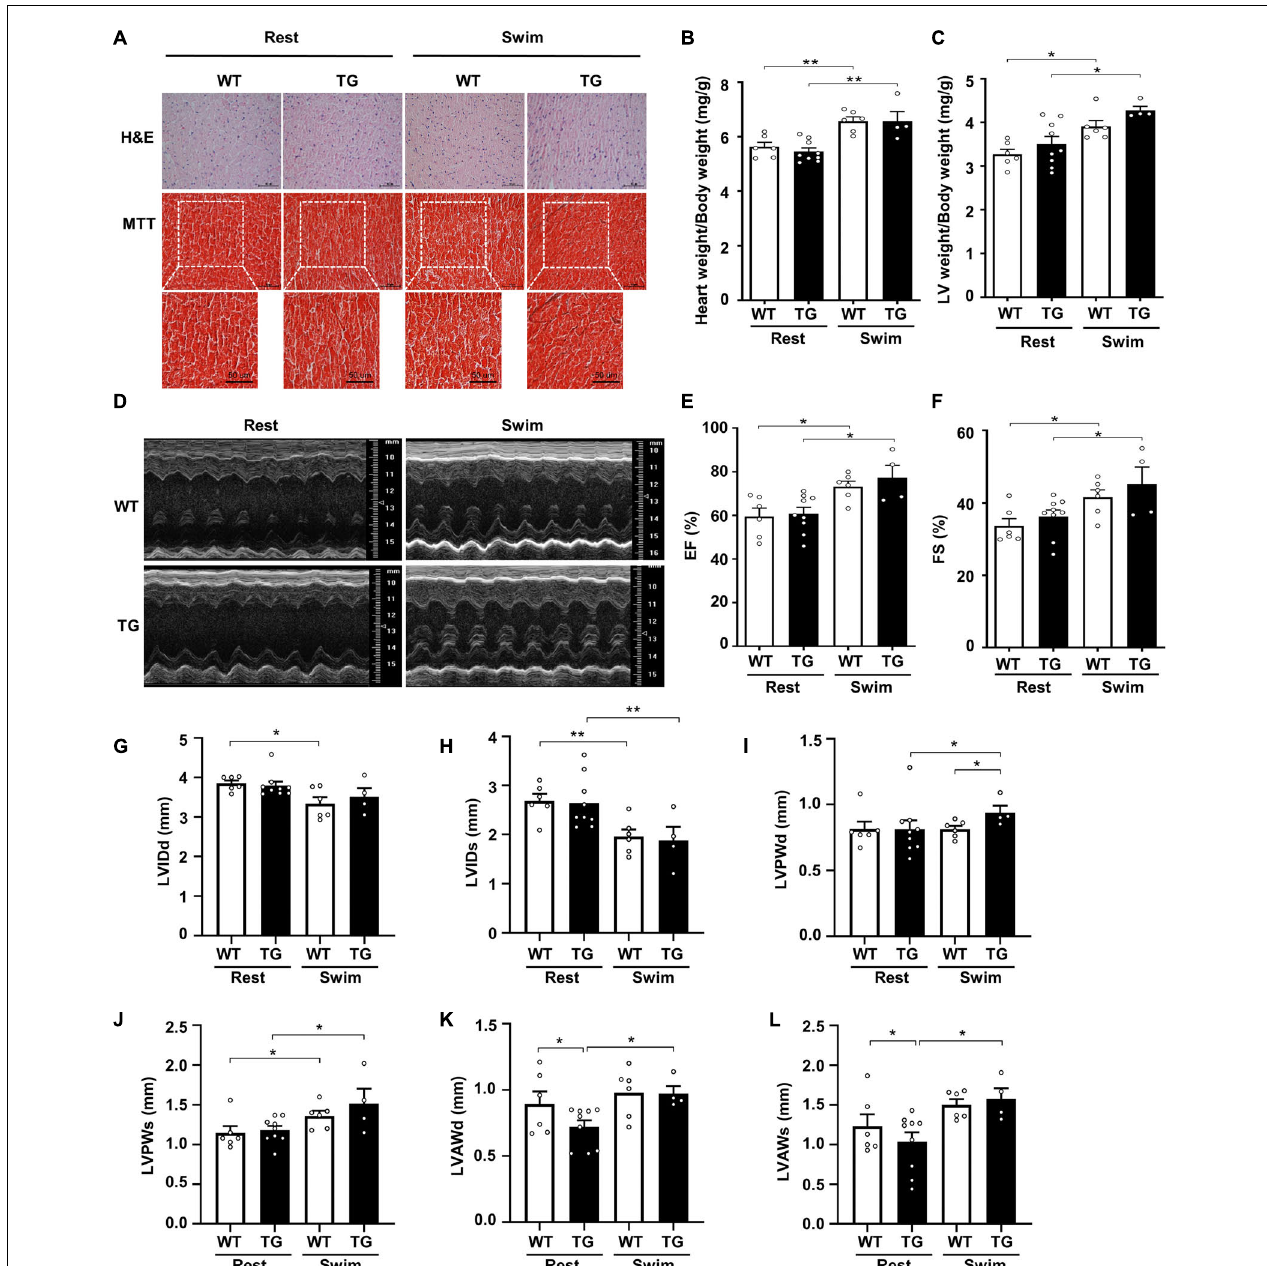
FIGURE 3 | Myocardial CKIP-1 overexpression does not affect physiological cardiac remodeling in response to swimming exercise. (A) CKIP-1 TG mice and WT littermates at 2 months of age were subjected to rest or swimming exercise. Histological sections from hearts were stained with H&E (scale bars, 50 µ m) and MTT to detect fibrosis (scale bars, 50 µ m). The ratios of heart weight to body weight (B) and LV mass to body weight (C) in WT and CKIP-1 TG mice after swimming exercise. Representative echocardiographic M-mode images (D) , ejection fraction (E) , and fractional shortening (F) evaluated by echocardiography in anesthetized WT and CKIP-1-TG mice with rest or swimming exercise. (G–L) Transthoracic echocardiography evaluating the left ventricular structure of WT and TG mice following swimming. Values are means ± SEM, n = 4 ∼ 9, ∗ P < 0.05, ∗∗ P < 0.01. Statistical differences among groups were analyzed by two-way analysis of variance (ANOVA) followed by the Bonferroni procedure. CKIP-1, casein kinase-2 interacting protein-1; WT, wild type; TG, transgenic; H&E, hematoxylin and eosin; MTT, Masson’s trichrome.